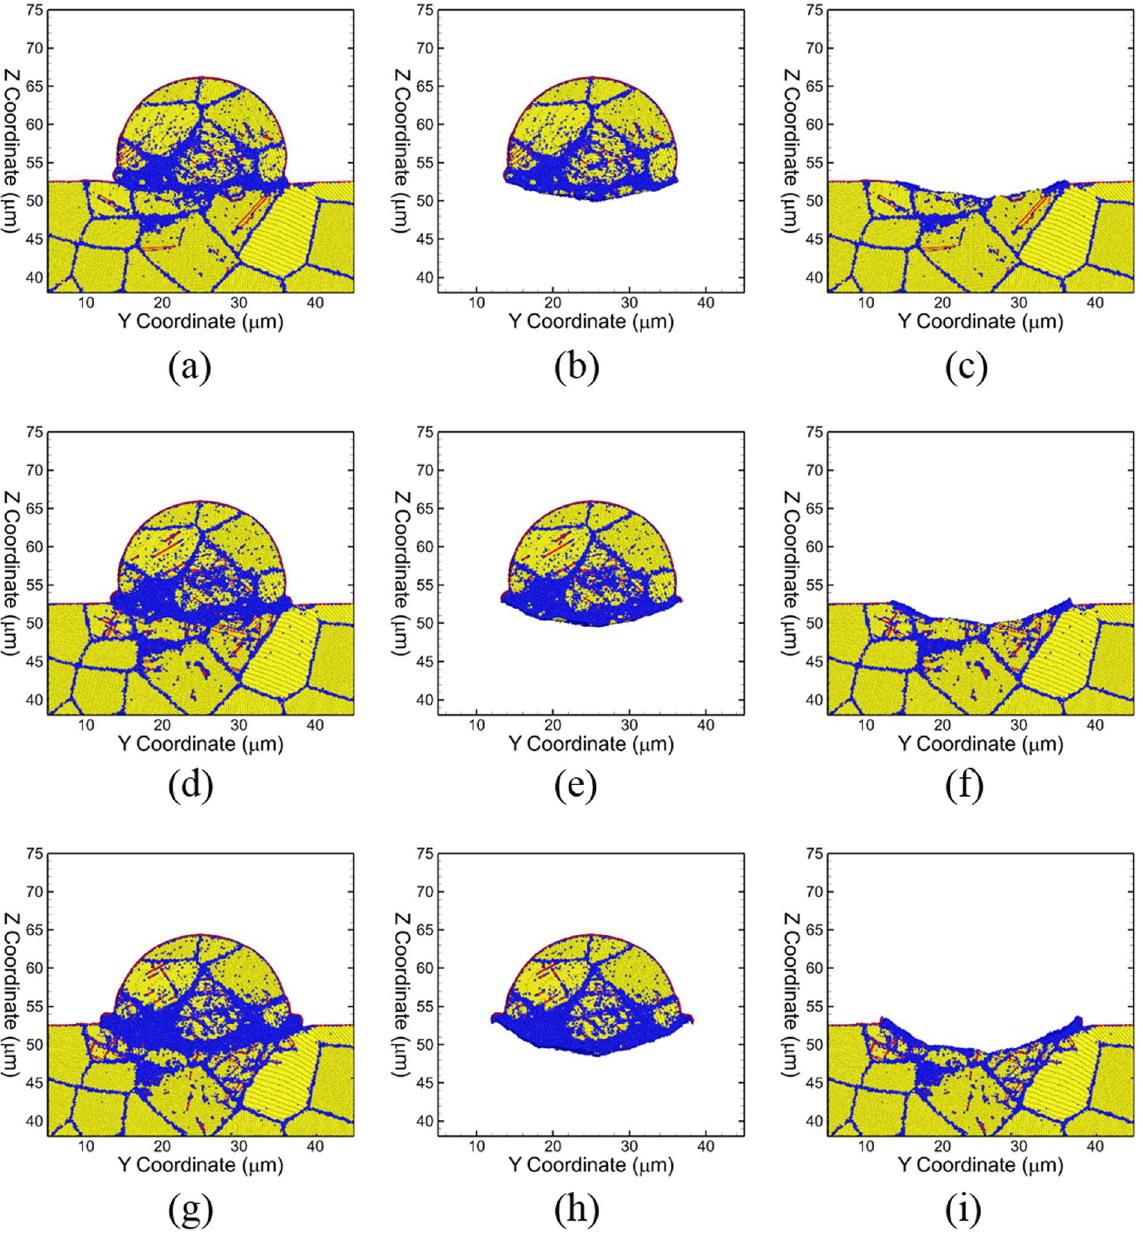
Figure 4. Snapshots showing microstructural features of (from L-R) the full system, particle and substrate respectively for velocities